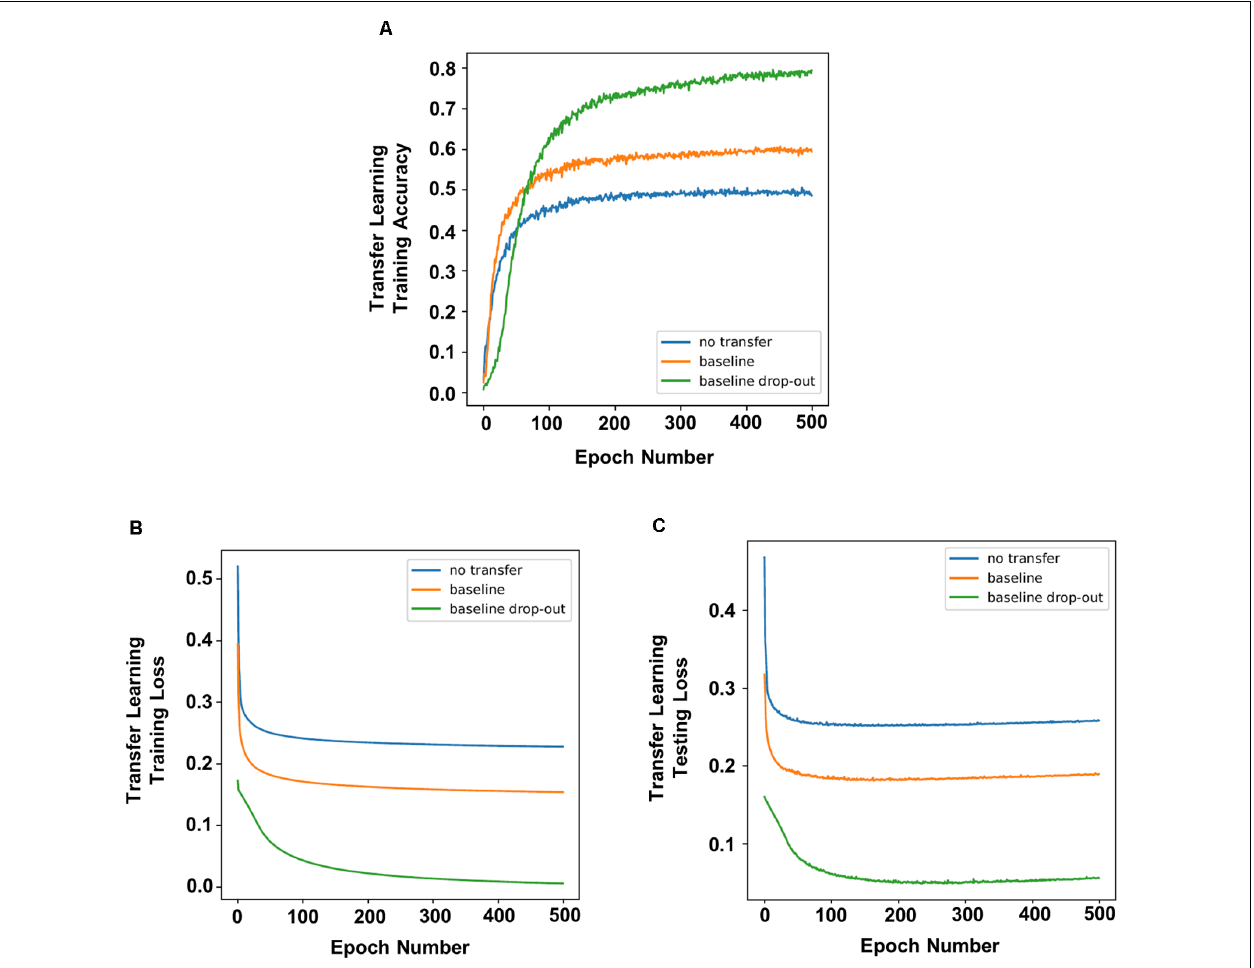
FIGURE 3 | Transfer learning of networks that underwent dropout showed higher prediction accuracy and faster learning. Compared to non-dropout networks, transfer learning of neural networks with dropout had increased accuracy (A) with lower training loss (B) and testing loss (C)